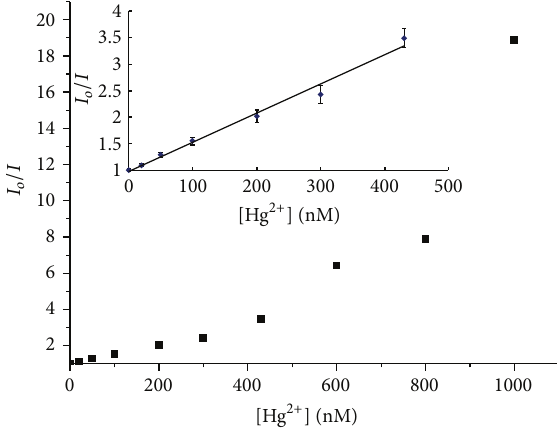
= Figure 2: Stern-Volmer relationship between PL intensity of CdTe em QDs and Hg(II) ions. The inset displays a linear Stern-Volmer plot at the low concentration range of Hg(II) ions with their error bars.